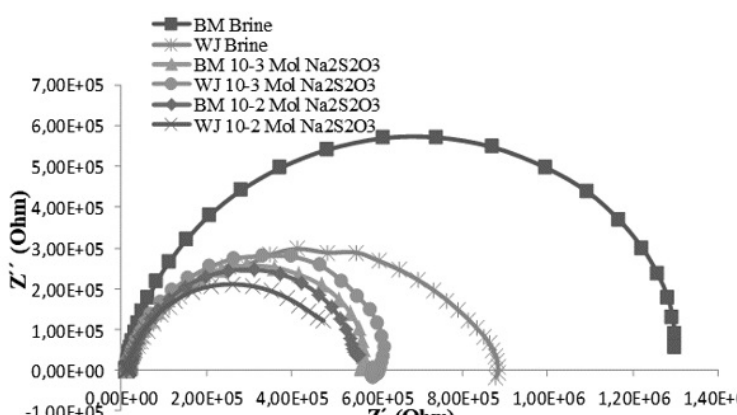
Figure 15. Characteristic Nyquist diagrams in different